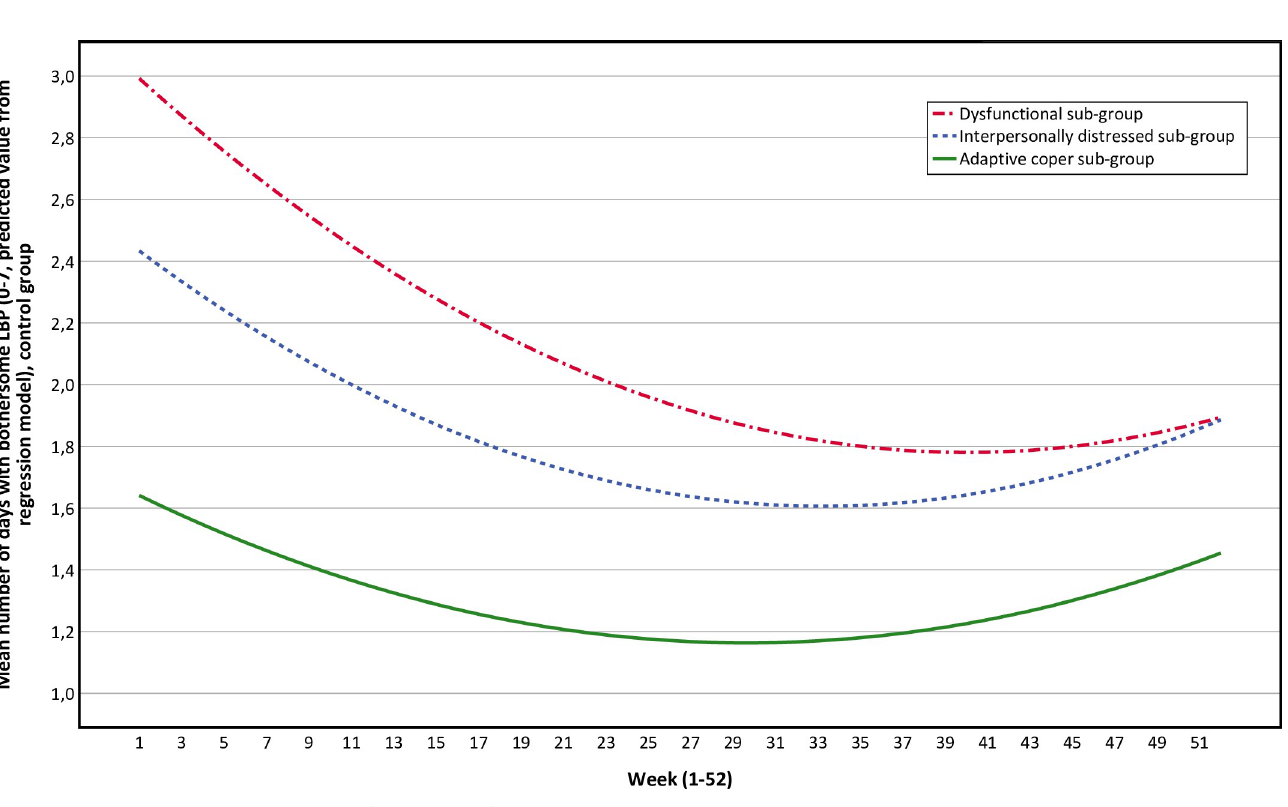
Fig 7. Pain trajectories for the control group (all sub-groups).